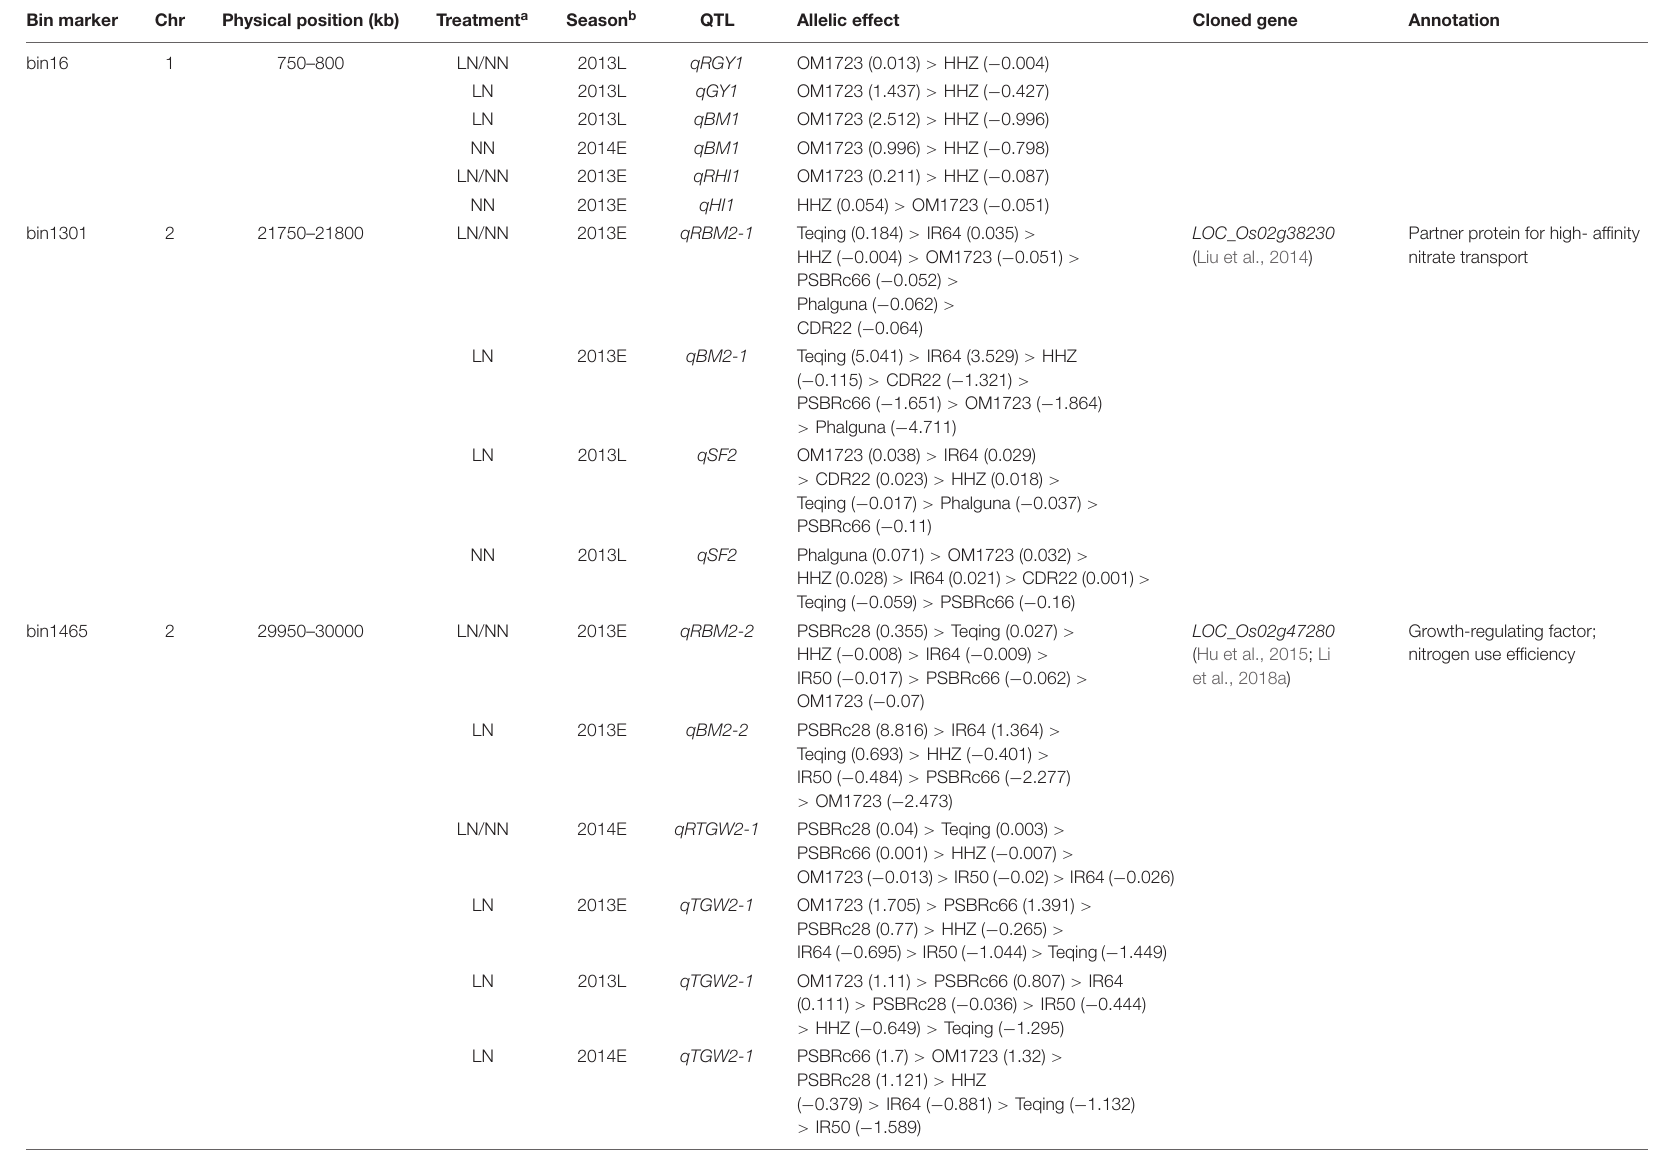
TABLE 3 | Effects of putative QTLs identified in this study and the previously cloned genes related to nitrogen deficiency